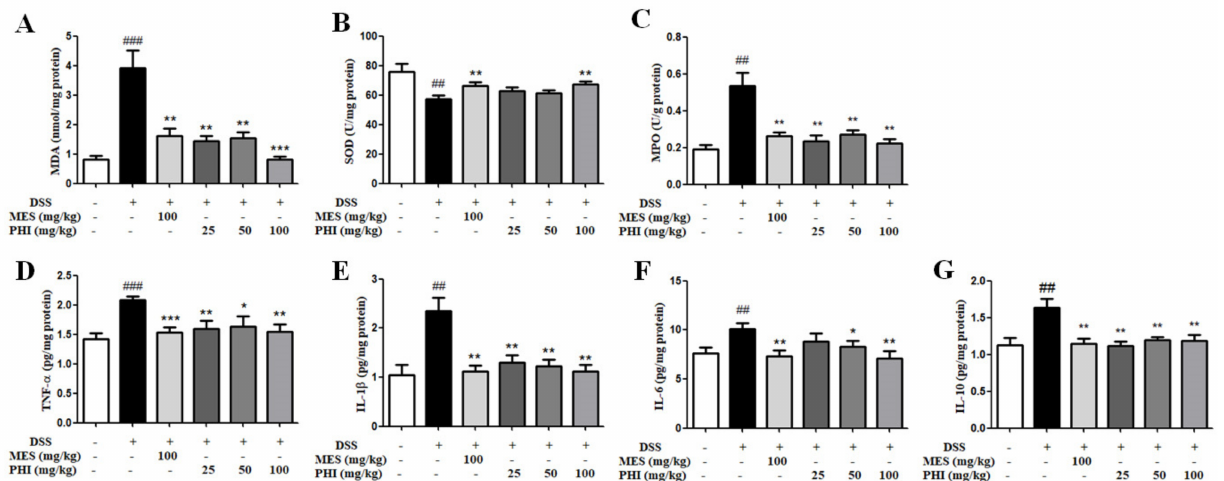
Figure 5. PHI inhibited the levels of oxidative stress and inflammatory cytokines. The oxidative stress levels ( A ) MDA, ( B ) SOD, and ( C ) MPO in colon tissues were determined according to the assay kit methods. The inflammatory cytokines ( D ) TNF- α , ( E ) IL-1 β , ( F ) IL-6, and ( G ) IL-10 in colon tissues were determined by ELISA. ## p < 0.01, and ### p < 0.00 1 vs. control group. * p < 0.05, ** p < 0.01, and *** p < 0.001 vs. DSS group. ( n = 10 mice per